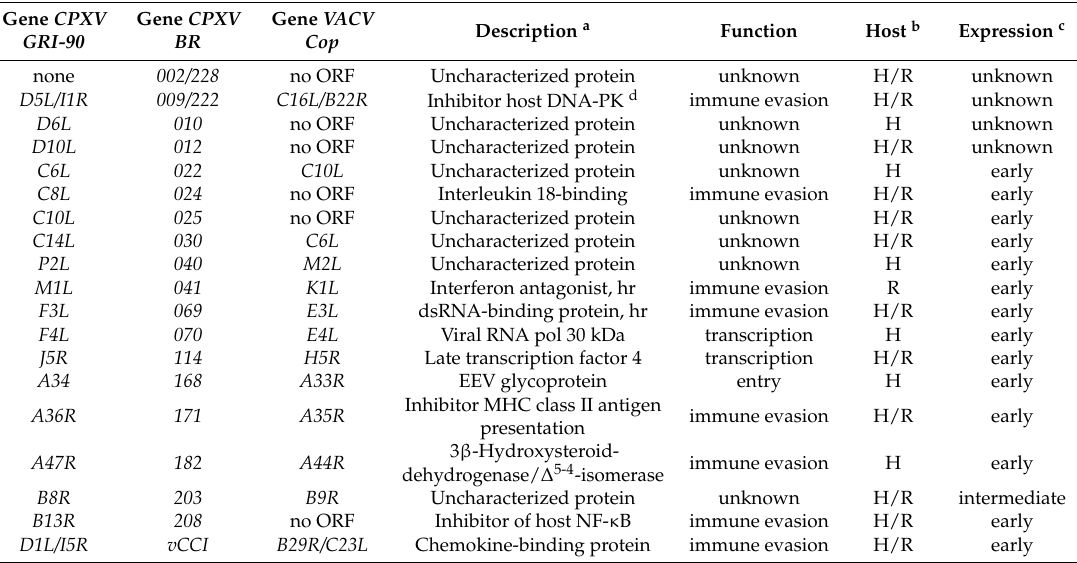
Table 1. Viral transcripts identified in CPXV